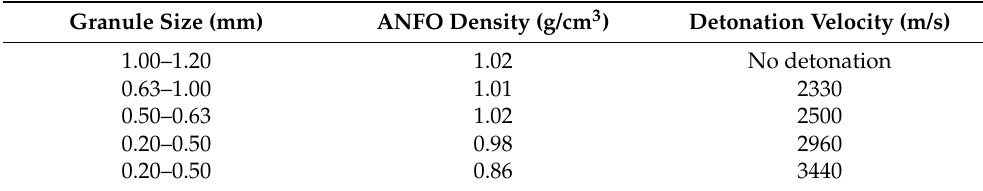
Table 3. Detonation velocity of ANFO prepared from AN granules of different sizes. Reprinted with the permission of John Wiley and Sons from [25].